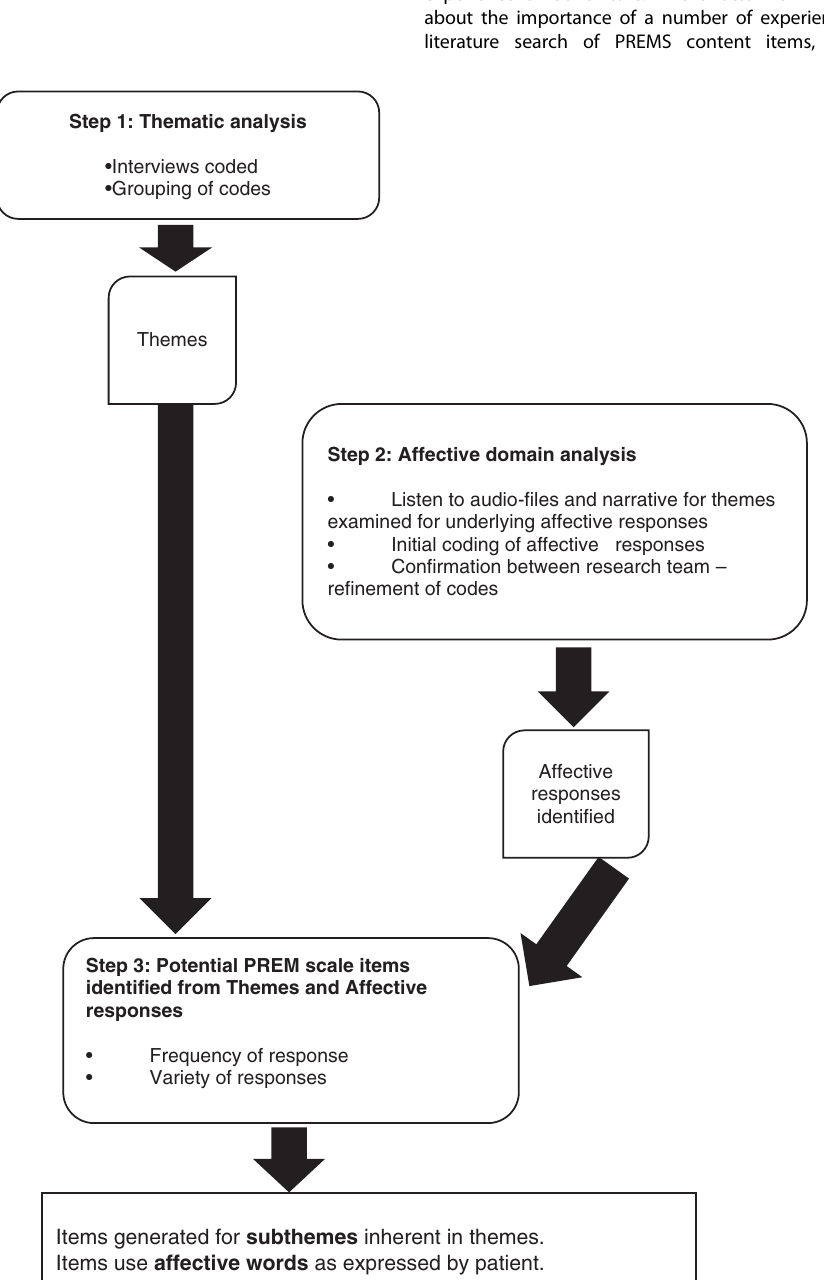
Fig. 2 Steps in data analysis